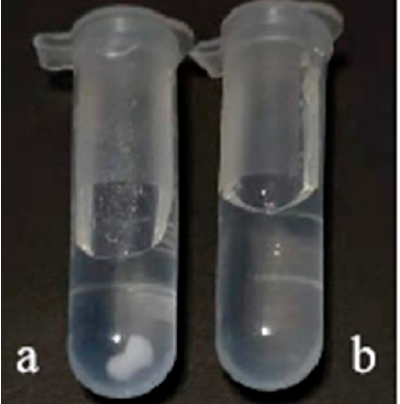
Figure 2. The solubility of yttrium carbonate in DES S and before ( a ) and after ( b ) mechanical activation.